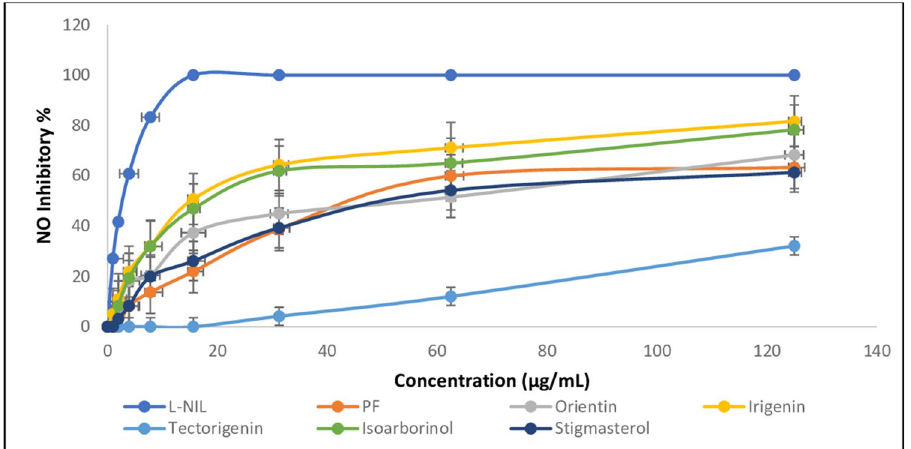
Figure 4. Effect of I. confusa fractions and isolated compounds on NO inhibition. All determinations were carried out in triplicate and values are expressed as the mean ± SD; L - NIL L- N 6 -(1-iminoethyl) lysine hydrochloride, PF polar fraction.